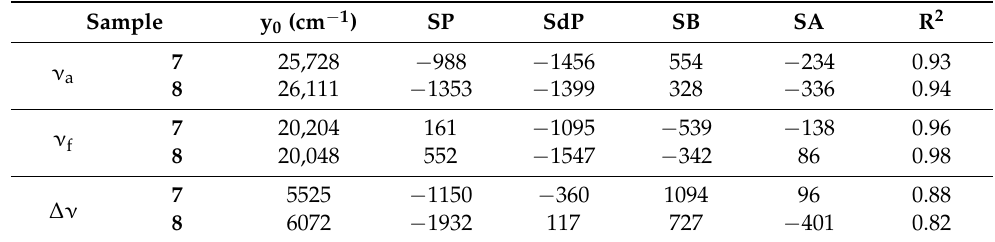
Table 5. Values of fitting parameters for naphthalimide derivatives according to Catalan model.